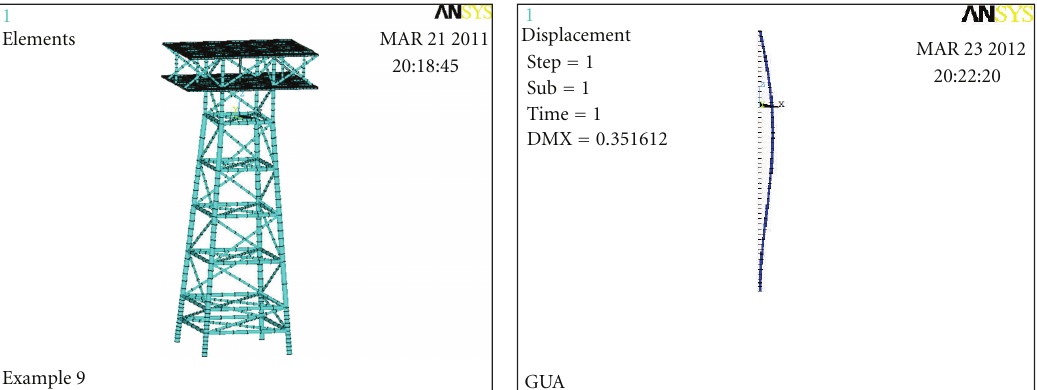
Figure 2: The Jacket platform model.